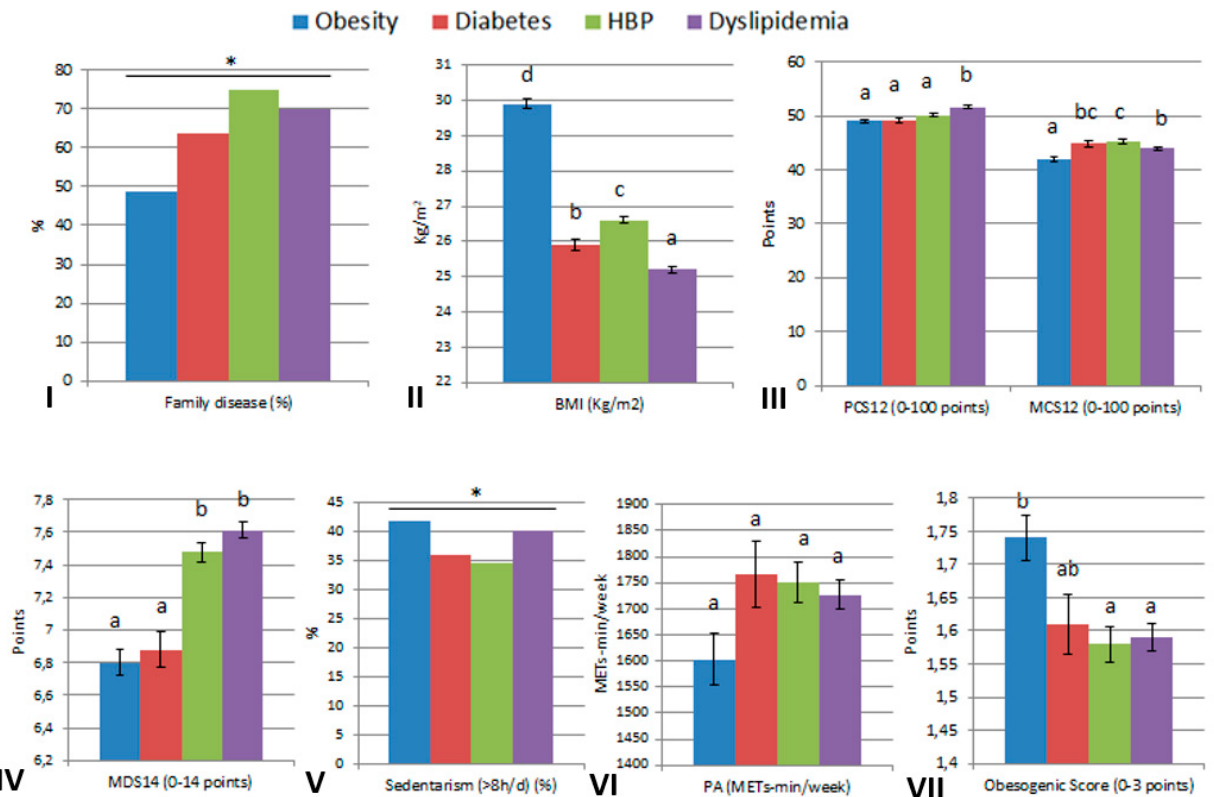
Figure 2. Characteristics of different diseases (obesity, diabetes, HBP and dyslipidemia). ( I ) Preva- lence of family disease (%). ( II ) BMI (Kg/m 2 ). ( III ) HRQoL score PCS12 and MCS12 (0–100 points). ( IV ) MDS14 (0–14 points). ( V ) Prevalence of sedentarism (%). ( VI ) Physical Activity (METs- min/week). ( VII ) Obesogenic Score (0–3 points). Family disease (%) refers to the same disease in each column. The statistics used to compare mean differences in Family disease (%) and sedentarism (%)